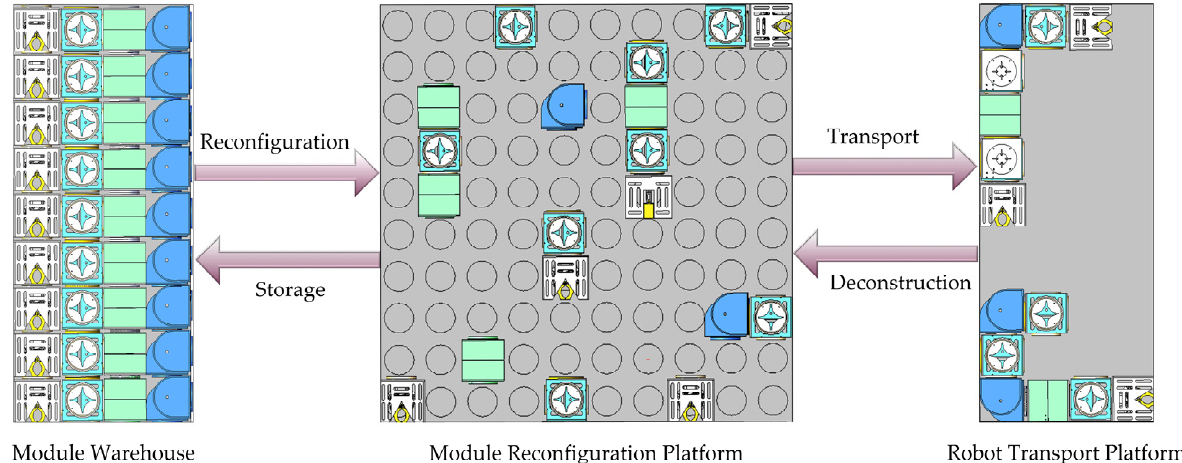
Figure 4. Distribution of the module reconfiguration system 226